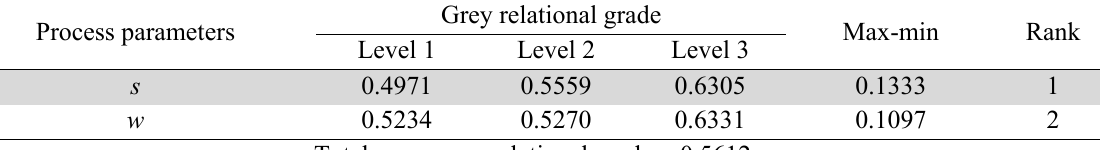
Process parameters